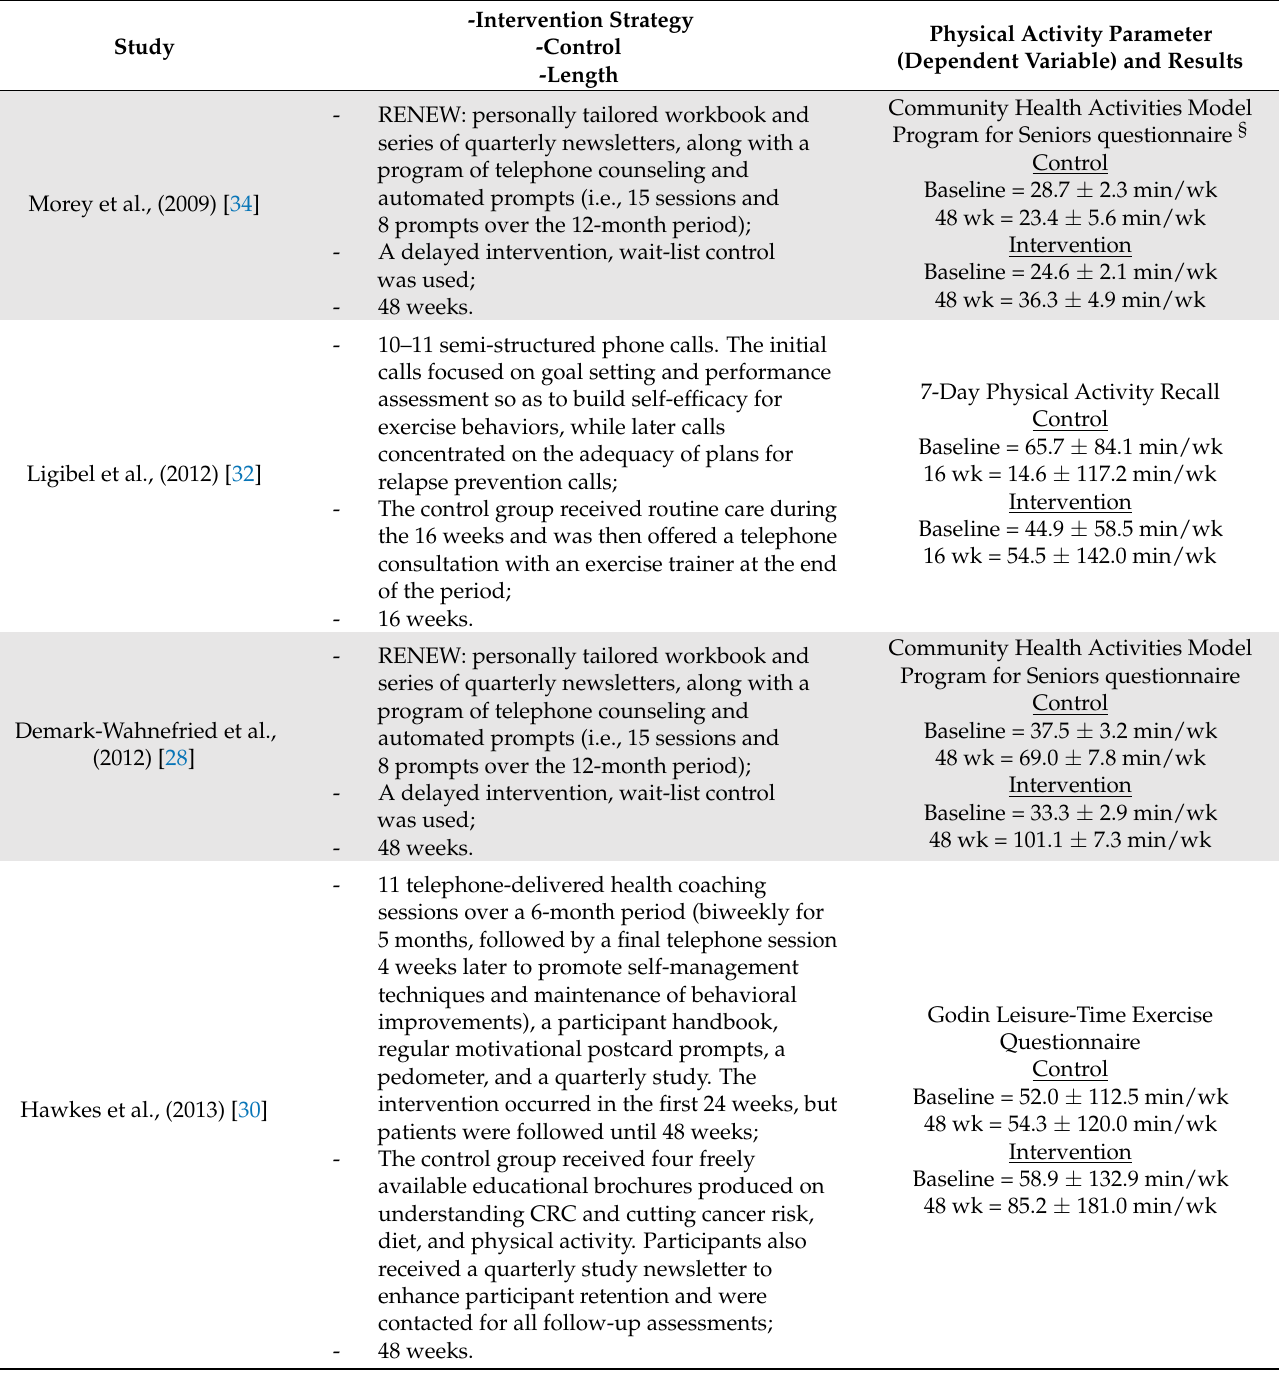
Table 2. Intervention strategy, length, and the results of the included studies in the qualitative